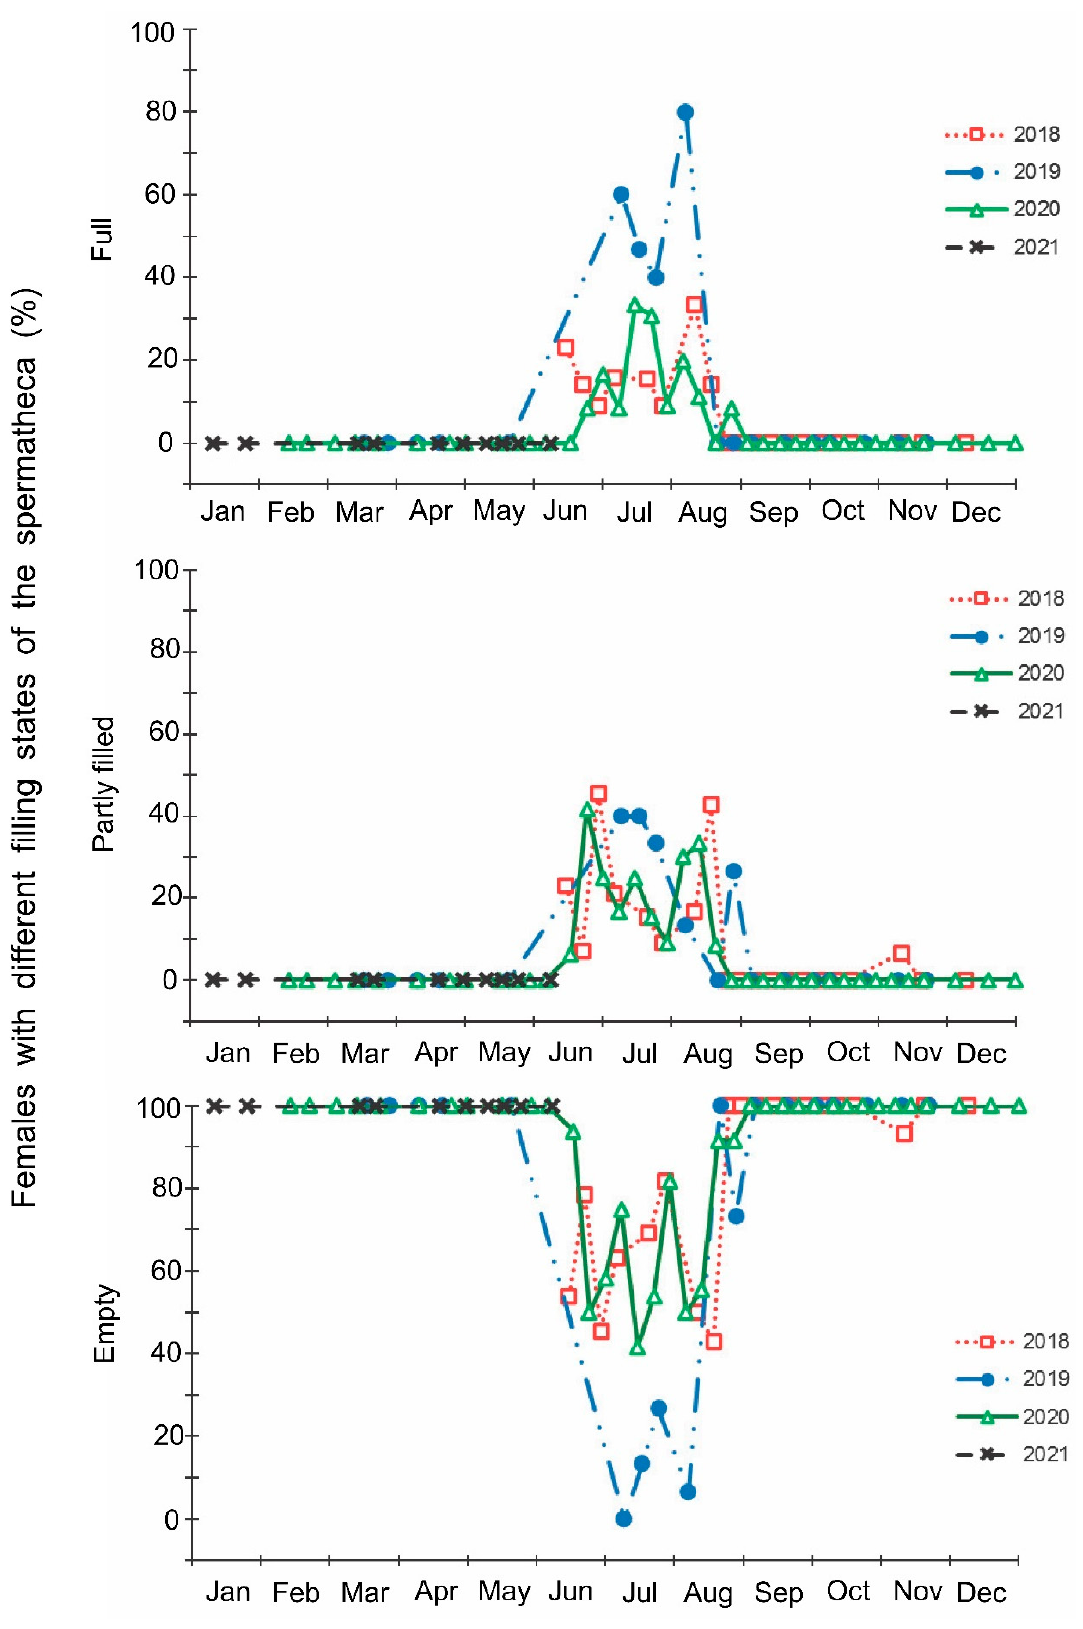
Figure 4. Seasonal changes in the proportions of Halyomorpha halys females with different filling states of the spermatheca during 2018–2021. Each symbol corresponds to one sample of field-collected females (6–35 females per sample with a total of 1180 females in 85 samples).